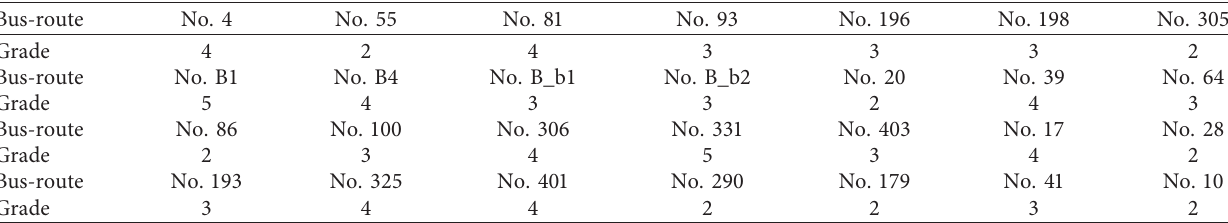
Table 5: Traditional T-S fuzzy neural-network evaluation of bus-line speed grade.